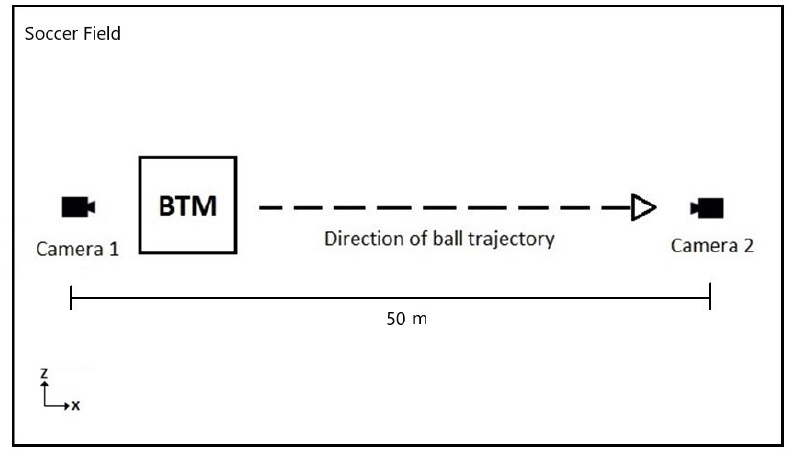
Figure 10. Experimental setup for kick trajectory analysis.